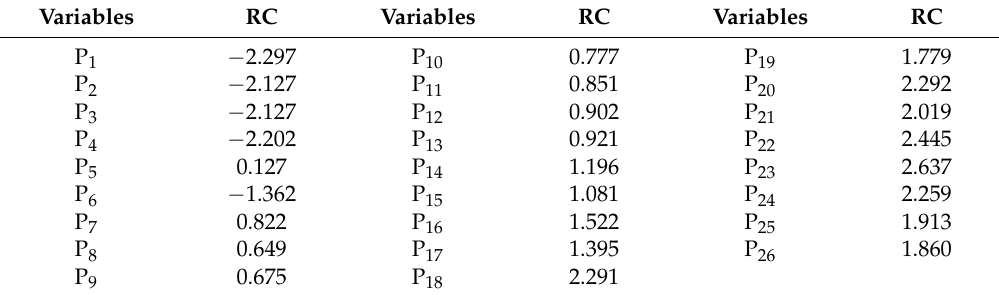
Table 6. RC between 26 components and ET-1 (Model Sig. <